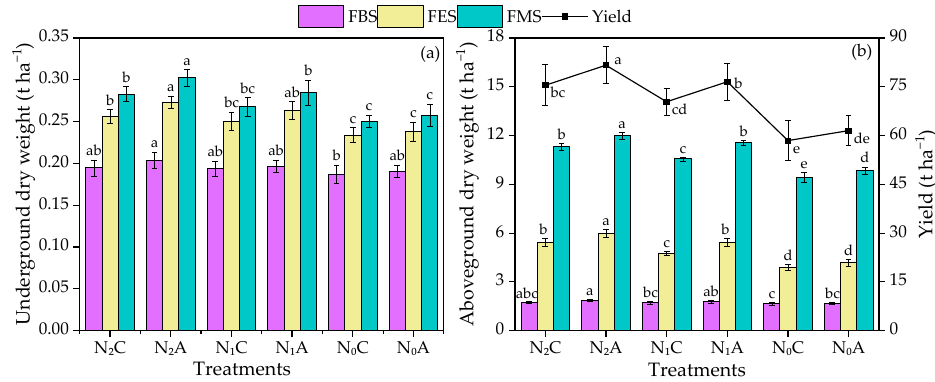
Figure 5. Plant dry matter and yield of tomato under different treatments at different growing stages. ( a ) is the underground dry weight of tomato, and ( b ) is the aboveground dry weight and yield of tomato. FBS, FES, and FMS represent the flowering and fruit bearing stage, the fruit expanding stage, and fruit mature stage, respectively. The different letters in the same column indicate significant differences at the level of 0.05.